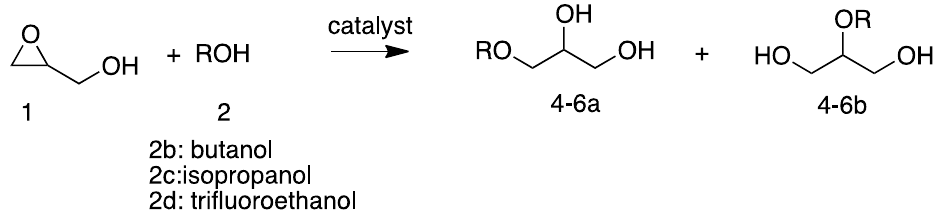
Table 2. Results of the reaction of glycidol with other alcohols at room temperature catalyzed by exchanged K10-Montmorillonites 1 .